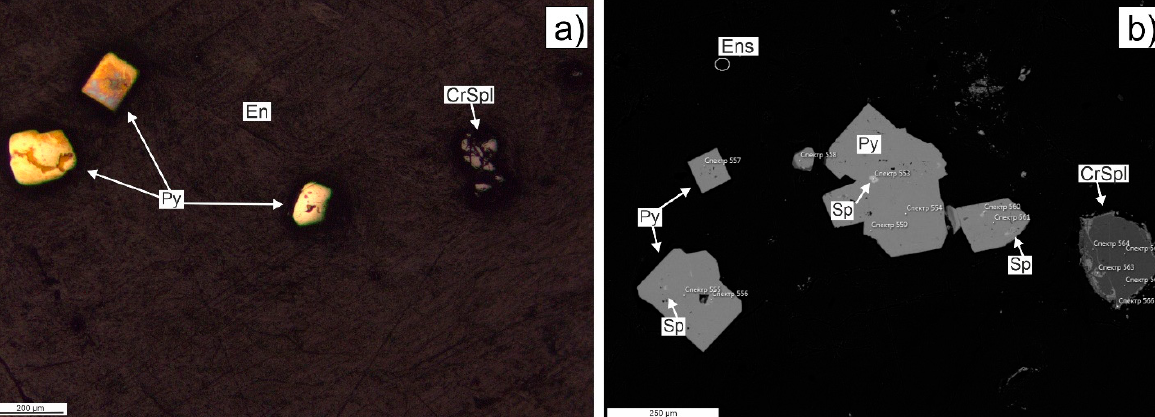
Figure 10. A general view of sample 242 with vein ‐ disseminated mineralization.